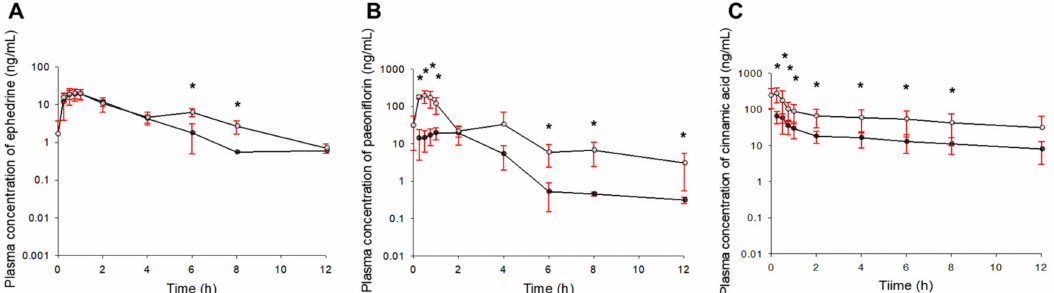
Figure 4. Mean plasma concentration–time profiles of ephedrine ( A ), paeoniflorin ( B ), and cinnamic acid ( C ) obtained after single (black-filled circles; from 0 to 12 h after dosing) or multiple (white-filled circles; from 120 to 132 h after dosing) oral administrations of SCRT to rats ( n = 5). The vertical bars represent standard deviations. * p < 0.05 between the single and multiple administration